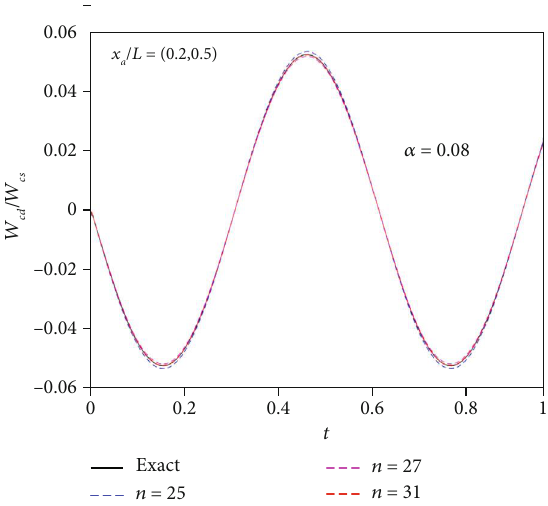
Figure 8: Convergence of numerical results for normalized central de fl ection of a simply supported beam excited by a harmonic piezoelectric actuator.